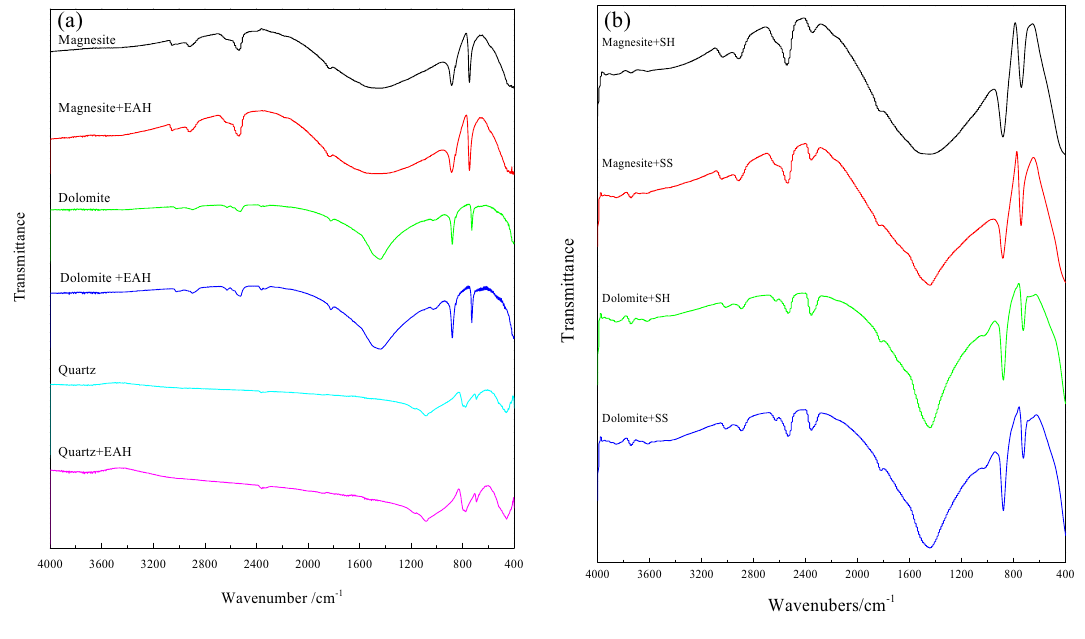
Figure 7. Infrared spectra of minerals and EAH ( a ), SH, SS ( b